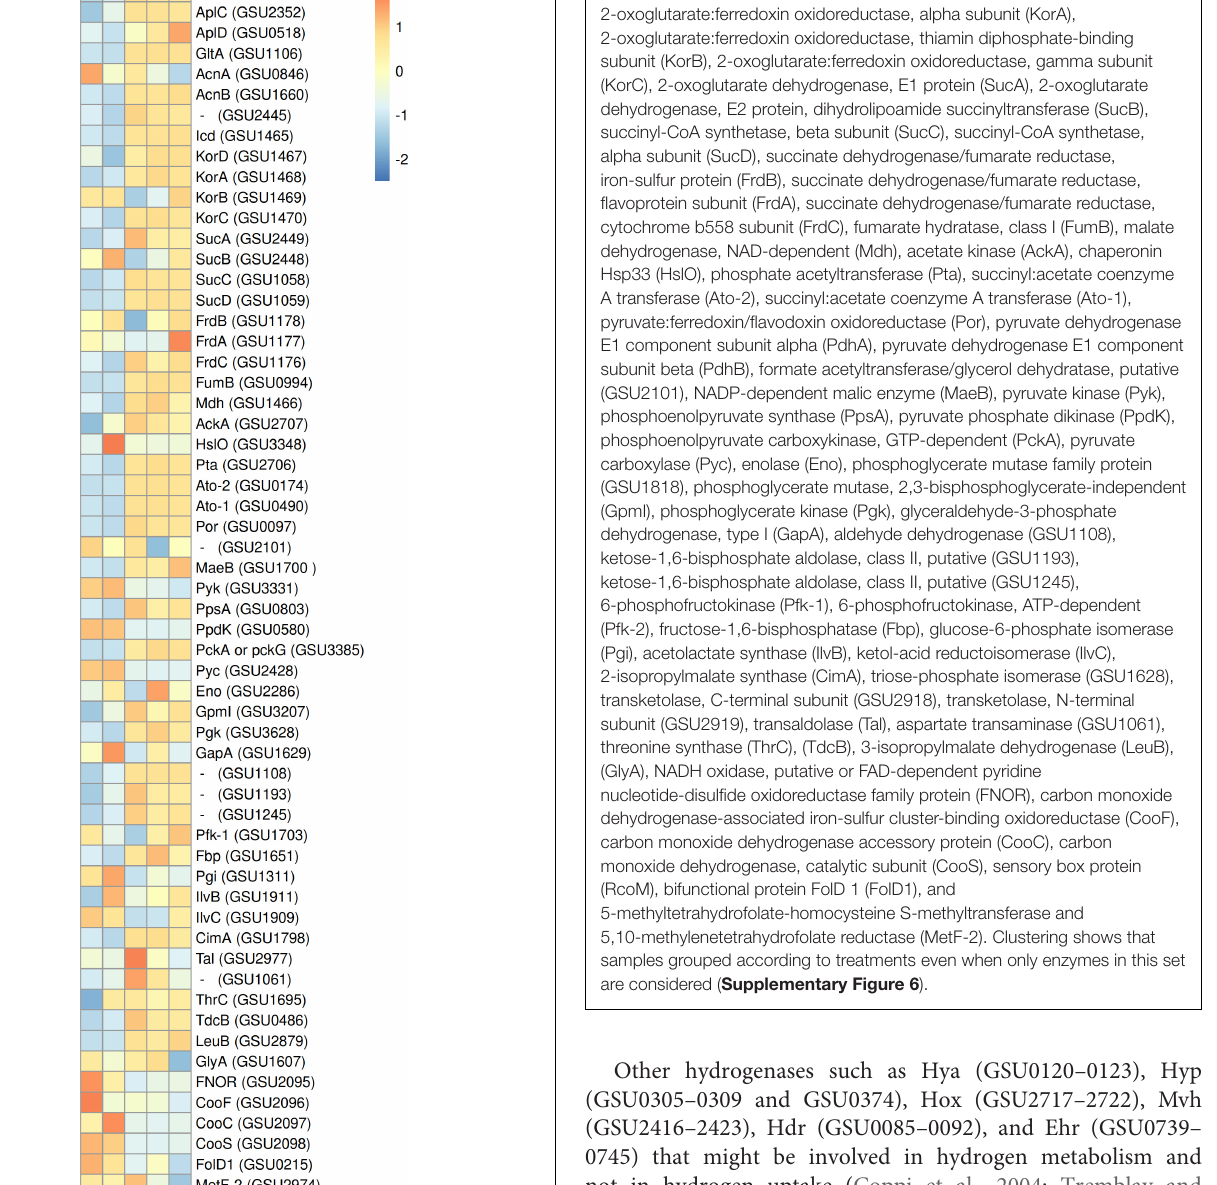
FIGURE 5 | putative (GSU2445), isocitrate dehydrogenase, NADP-dependent (Icd), 2-oxoglutarate:ferredoxin oxidoreductase, ferredoxin subunit